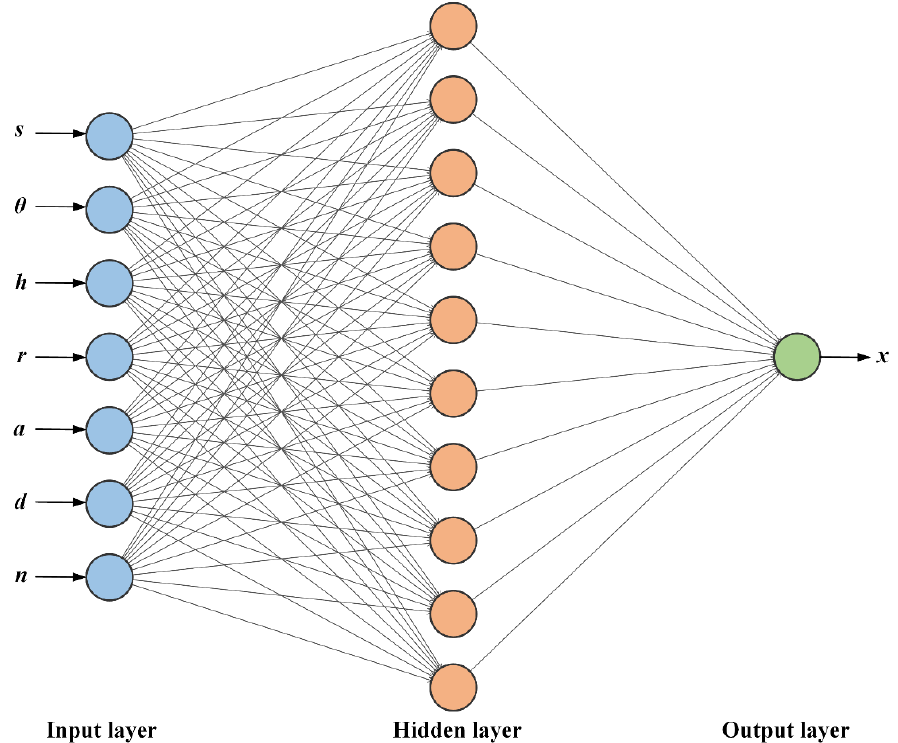
Figure 9. Statistical performance of the BPNN model with different transfer functions and hidden neurons in the testing stage.